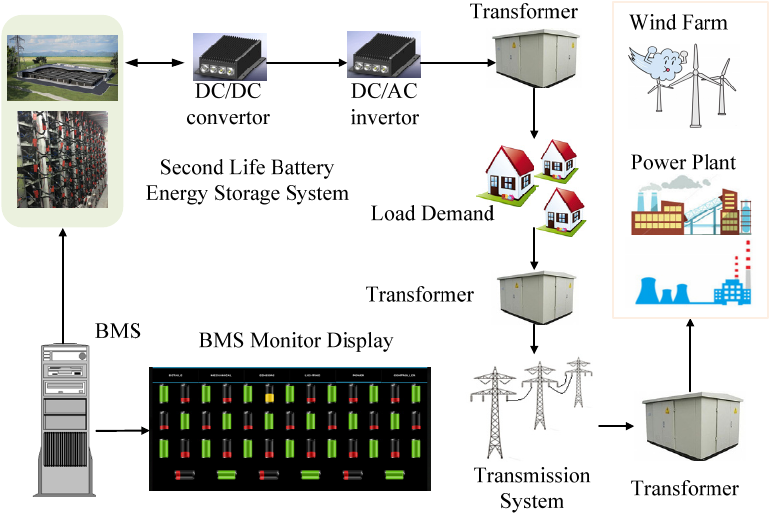
Figure 4. Schematic diagram of the proposed power grid.